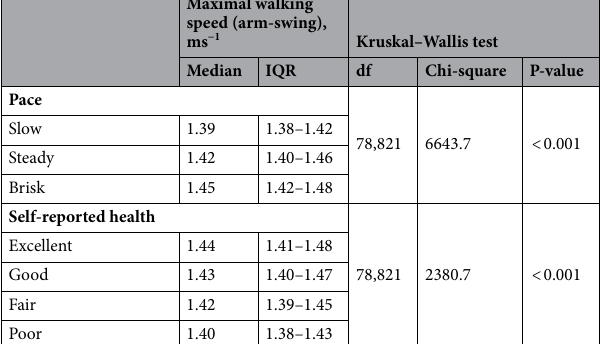
Maximal walking speed (arm-swing), ms